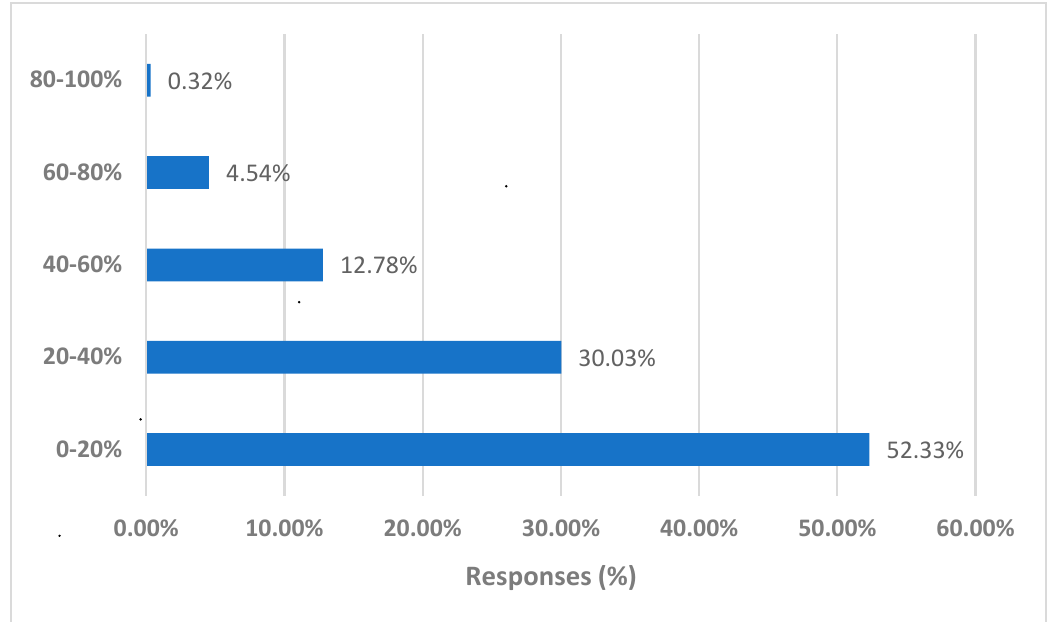
Figure 7. Responses to “Which is the percent of food waste in the total amount of household waste?”